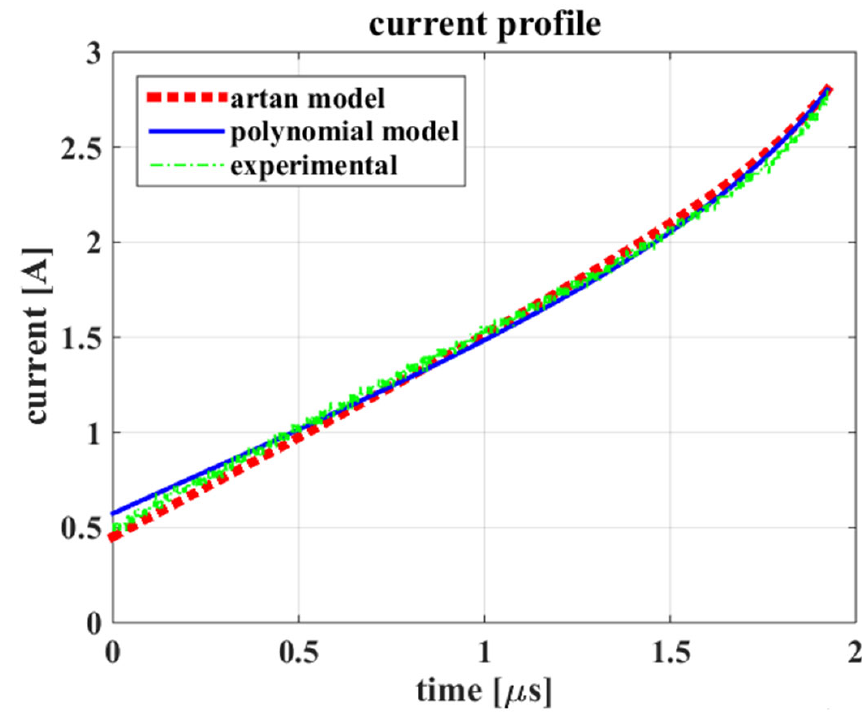
Figure 9. Current profile obtained by the two models and experimental points.